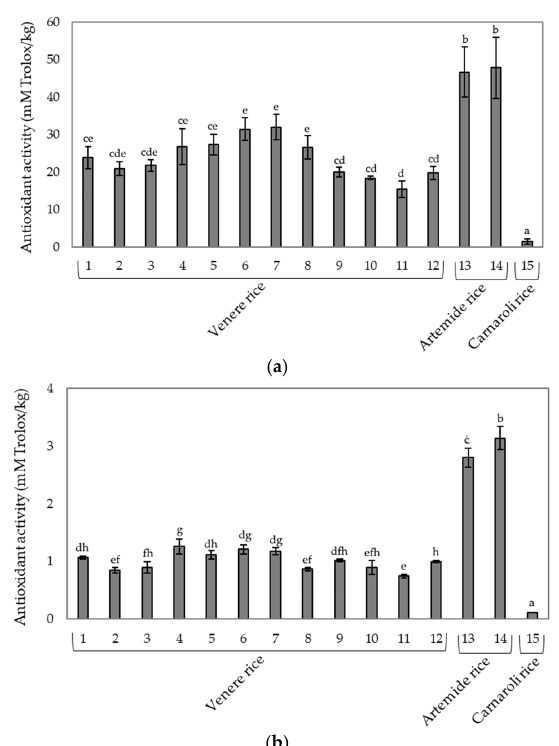
Figure 2. Antioxidant activity in raw rice cultivars determined by ( a ) 2,2-diphenyl-1-picrylhydrazyl (DPPH) assay and ( b ) 2,2 ′ -azino-bis(3-ethylbenzothiazoline-6-sulphonic acid) (ABTS) assay. Different letters mean significant differences ( p < 0.05).